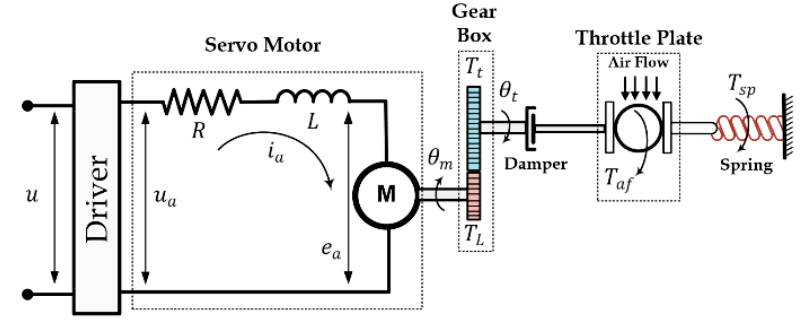
Figure 2. The schematic diagram of throttle valve.